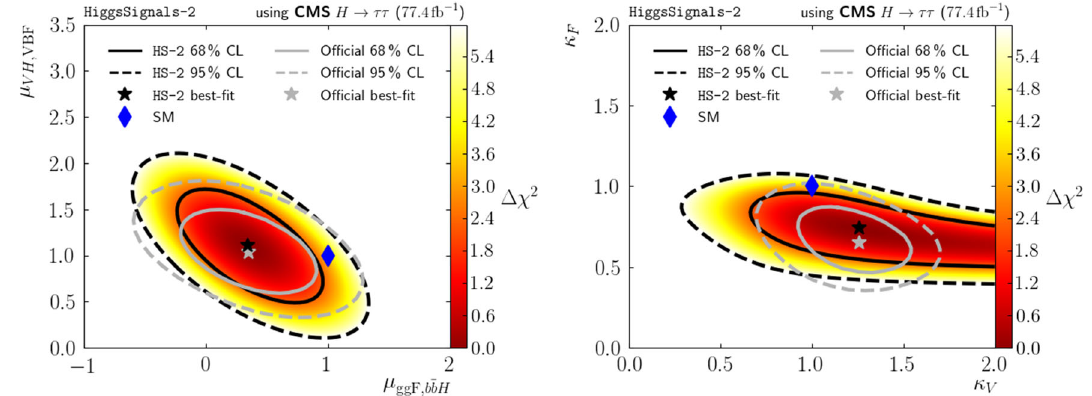
,μ Fig. 12 Performance test in the ( μ solid(dashed) contours correspond tothe 68% C.L. (95% C.L.)regions. VH , VBF ) (left panel) ggF , b ¯ bH and ( κ V ,κ F ) parameter plane (right panel) using the STXS mea- The HiggsSignals results are shown in dark and the official results surements of the CMS H → ττ analysis with 77 fb − 1 [64] as in light shades. The diamonds indicate the SM HiggsSignals input. The stars indicate the best fit points, and the